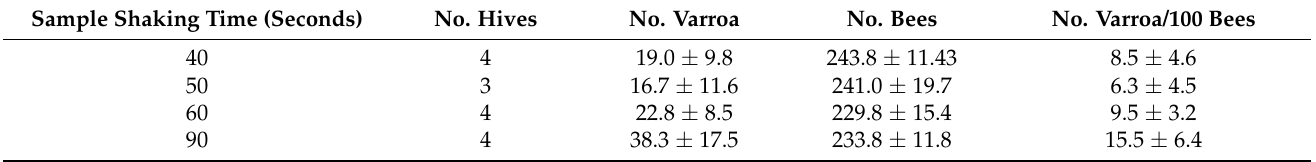
Table 3. Summary statistics for tests of VSD shaking time for estimation of Varroa recovery efficiency. The numbers (mean ± standard err (se)) of Varroa collected in each of the bee samples, the number of bees in each sample, and number of mites adjusted as the number of mites per 100 honey bees.